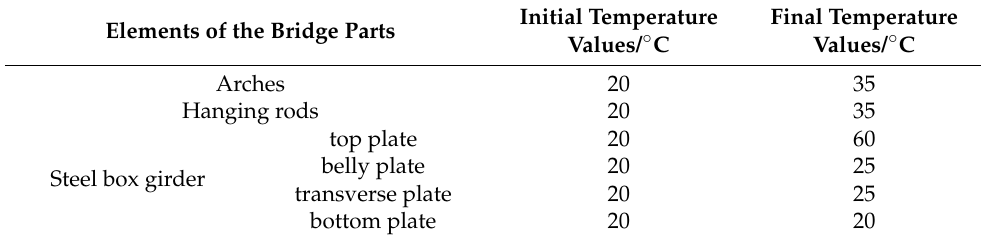
Table 2. Temperature values of the elements of bridge parts in the FE model. Elements of the Bridge Parts